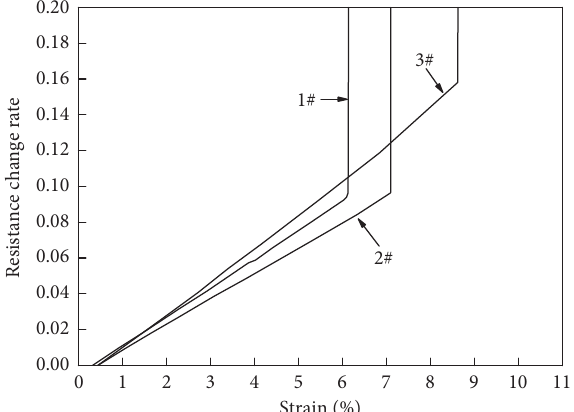
Figure 9: Curve of strain and resistance change rate of the carbon nanotube